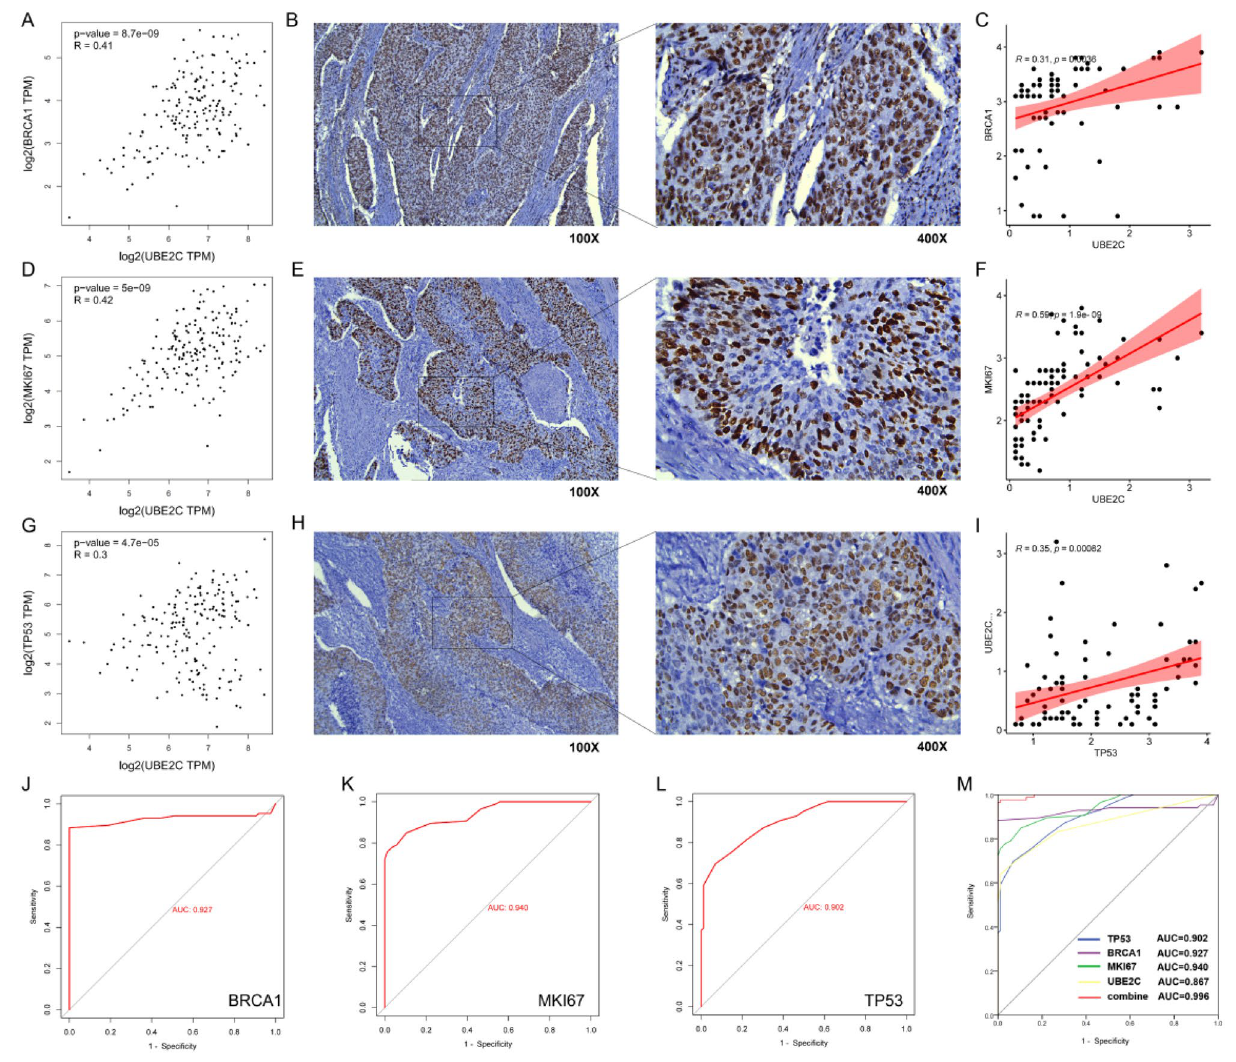
Figure 12. Correlation analysis between UBE2C and clinical markers and evaluation of combined diagnostic effect. ( A , D , G ) The correlation between UBE2C and clinical markers (BRCA1, KI67 and TP53) in esophageal cancer was analyzed by GEPIA database. R represents the correlation coefficient. ( B , E , H ) Expression of clinical markers (BRCA1, KI67 and TP53) in esophageal cancer. The brown part represents the target protein. ( C , F , I ) The correlation between UBE2C and clinical markers (BRCA1, KI67 and TP53) was analyzed according to the results of clinical immunohistochemistry. (J-L) ROC curve was used to analyze the diagnostic efficacy of clinical markers (BRCA1, KI67 and TP53) in esophageal cancer. ( M ) Efficacy of UBE2C combined with clinical markers (BRCA1, KI67 and TP53) in the diagnosis of esophageal